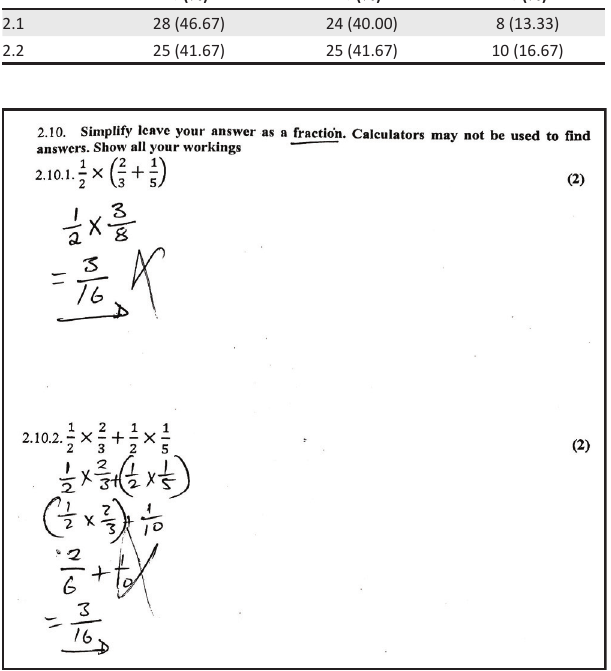
FIGURE 5: The response of T38 to multiplication and addition of fractions with different denominators.